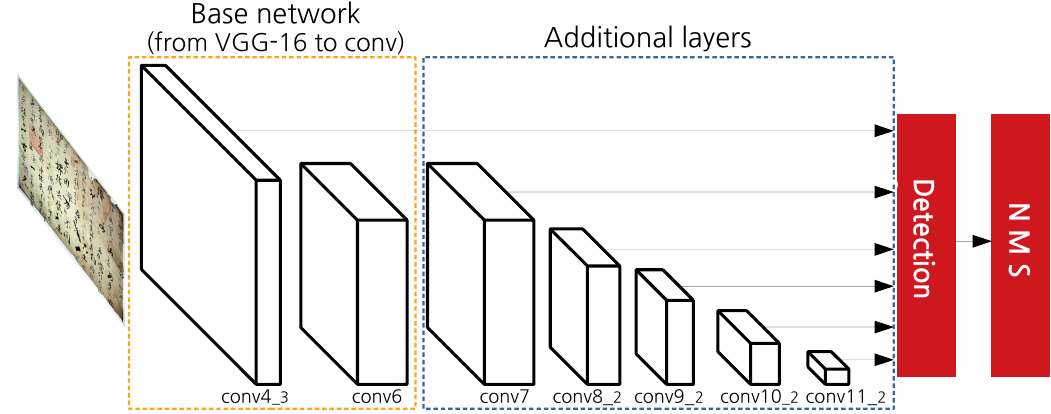
Figure 2. Network architecture of the conventional